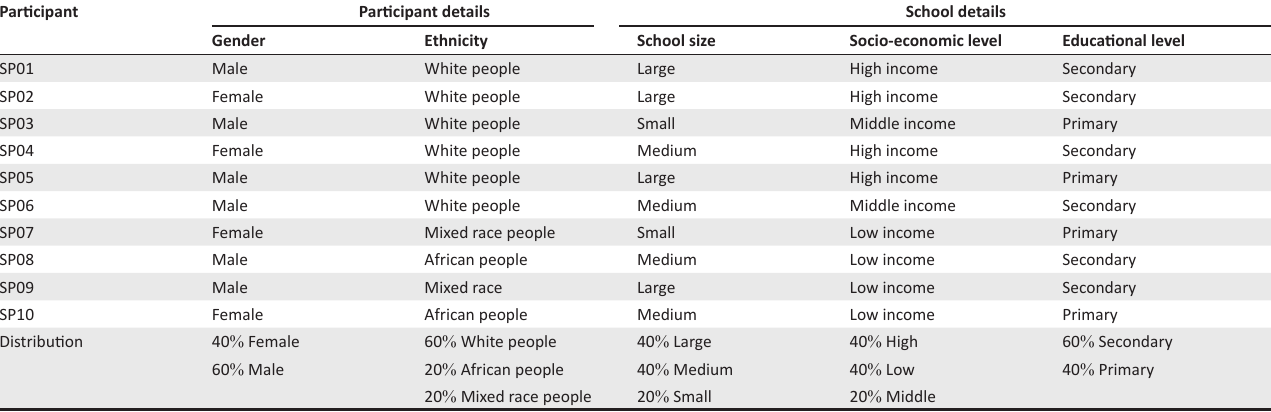
TABLE 2: Participant and school sampling